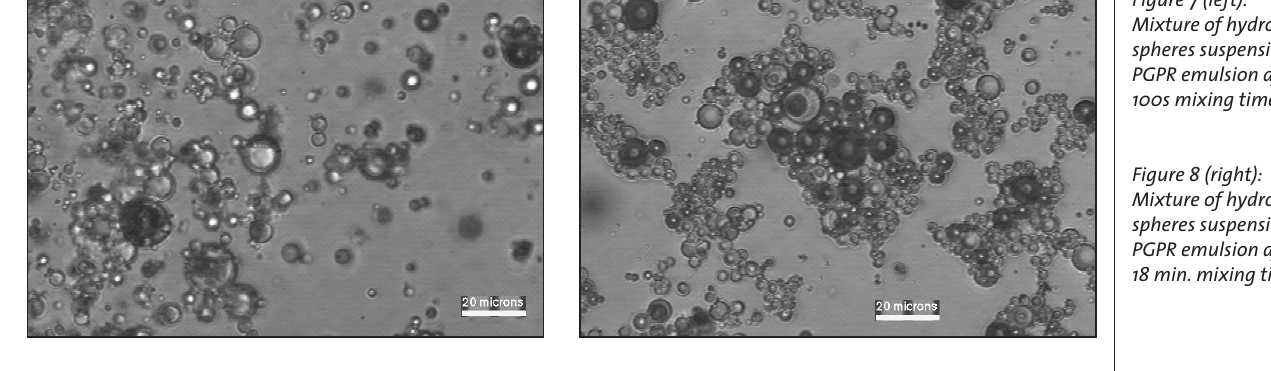
interactions with other suspension particles.